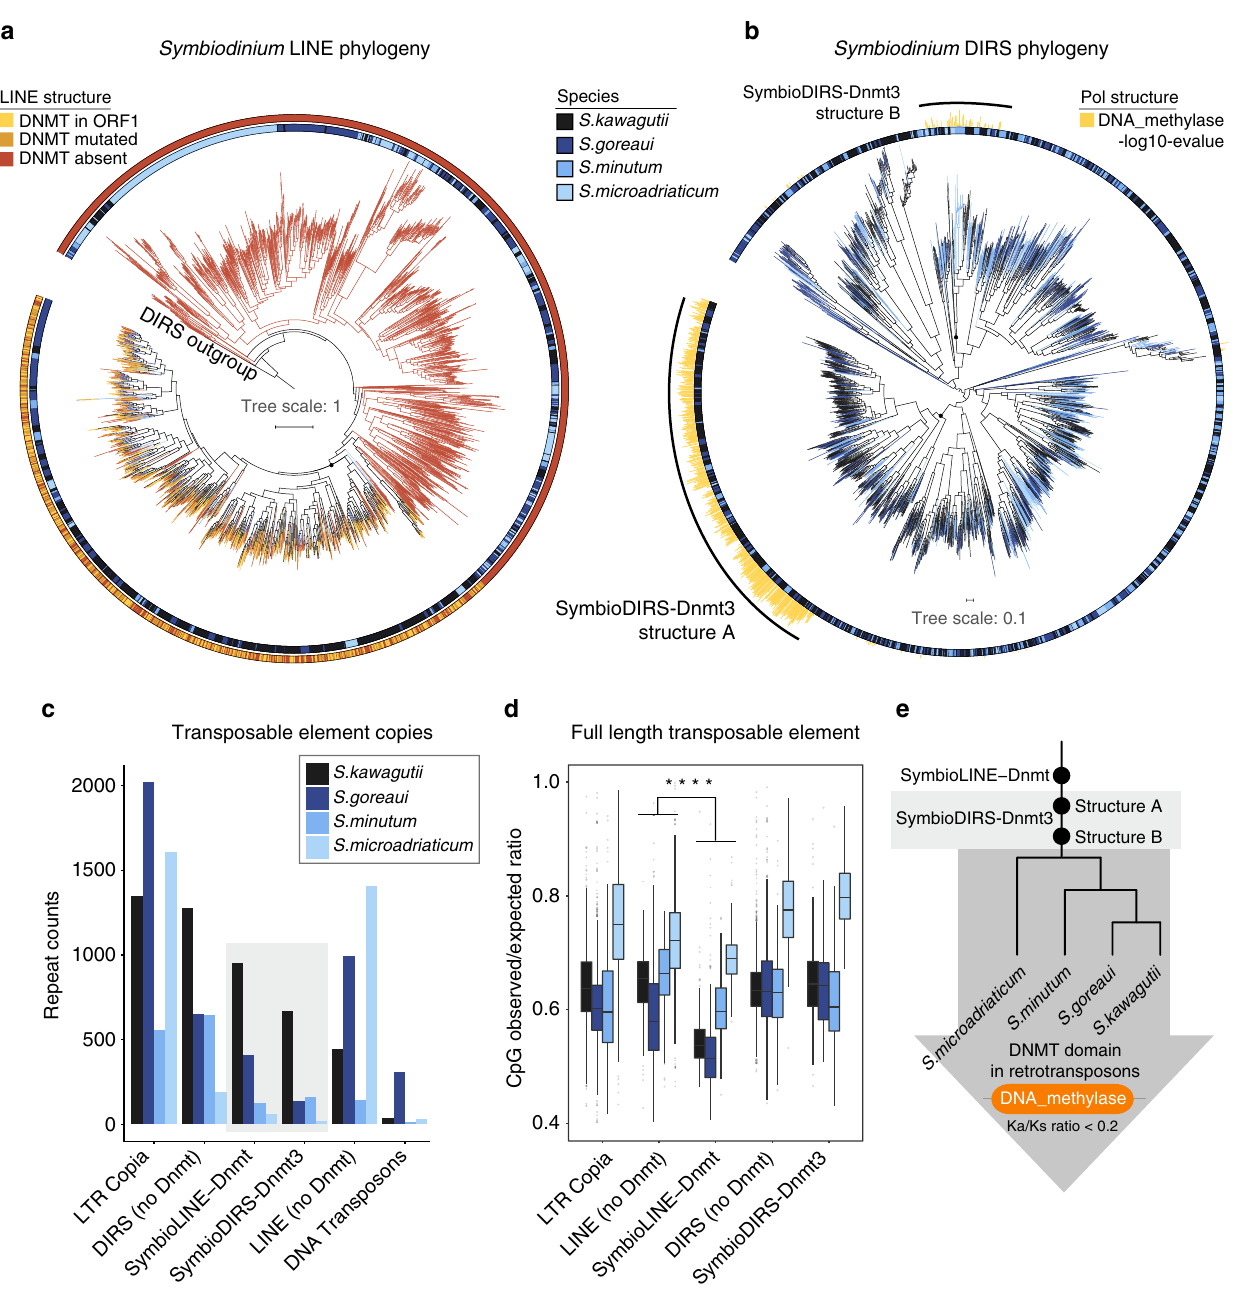
Fig. 2 DNMT-retrotransposon evolutionary dynamics in Symbiodinium . a Maximum likelihood phylogenetic tree based on the ORF2 of Symbiodinium LINE retrotransposons, rooted using DIRS reverse transcriptases as an outgroup. The internal circle indicates species af fi liation of each sequence and the outer circle indicates the architecture of the LINE element. DNMT mutated indicates that there are premature stop codons in ORF1 or ORF2. DNMT absent implies that there is no evidence of upstream ORF1 encoding a DNMT. b Maximum likelihood phylogenetic tree based on Pol ORF (retrotranscriptase and RNase_H domains) of DIRS-like retrotransposons. The inner circle indicates species af fi liation and the barplot indicates the degree of DNMT conservation based on a hmmsearch alignment e -value. c Number of transposable element copies in each Symbiodinium species. d Comparison of the CG observed/ expected ratio across all Symbiodinium retrotransposon types. SymbioLINE-DNMTs have fewer CGs than the rest (asterisks represent Wilcoxon one-sided rank-sum test p < 0.01) of retrotransposons in all four species, while SymbioDIRS-Dnmt do not show a signi fi cant difference when compared to DIRS elements without DNMT ( p > 0.01). Boxplot centre lines are medians, box limits are quartiles 1 (Q1) and 3 (Q3), whiskers are 1.5 × interquartile range (IQR) and points are outliers. e Schematic species tree of Symbiodinium species showing the evolutionary origins of DNMT encoding retrotransposons in this lineage and the subsequent conservation of DNMT domain as shown in Supplementary Figs. 8 and 9. Phylogenetic relationships between Symbiodinium species is based on previous publications 24,